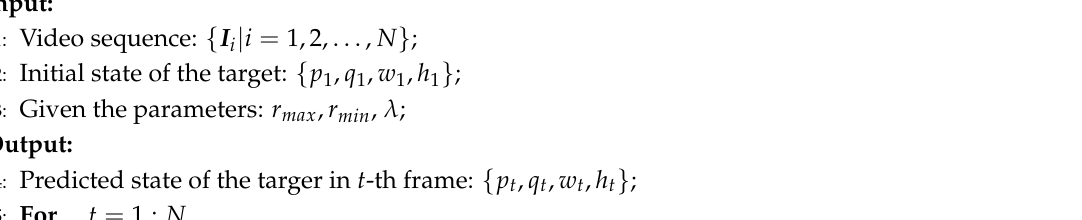
Algorithm 2 Online semantic subspace learning with siamese network